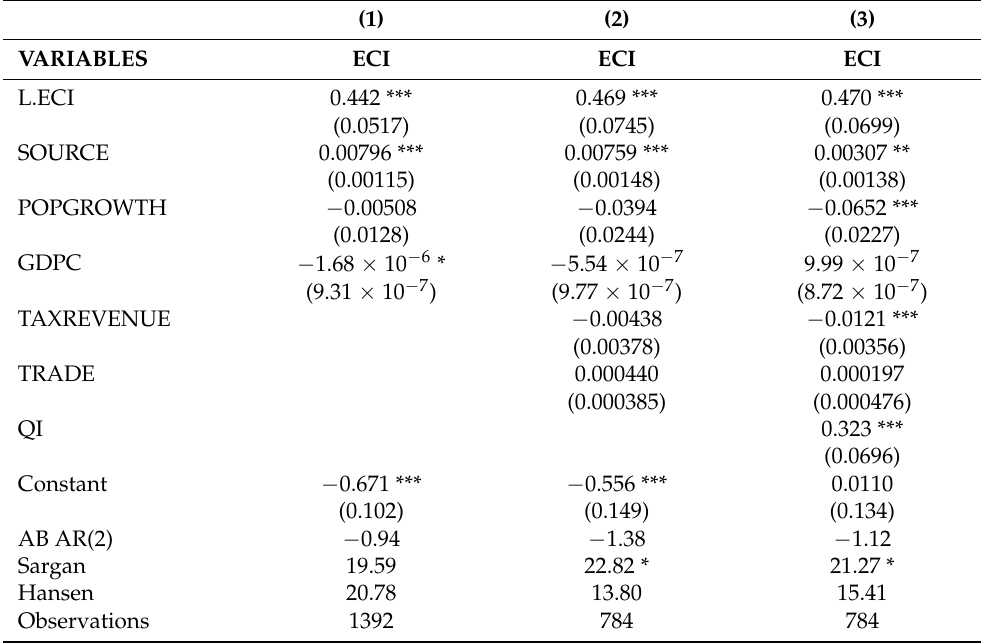
Table 7. Results of regression models (based on source data assessment of statistical